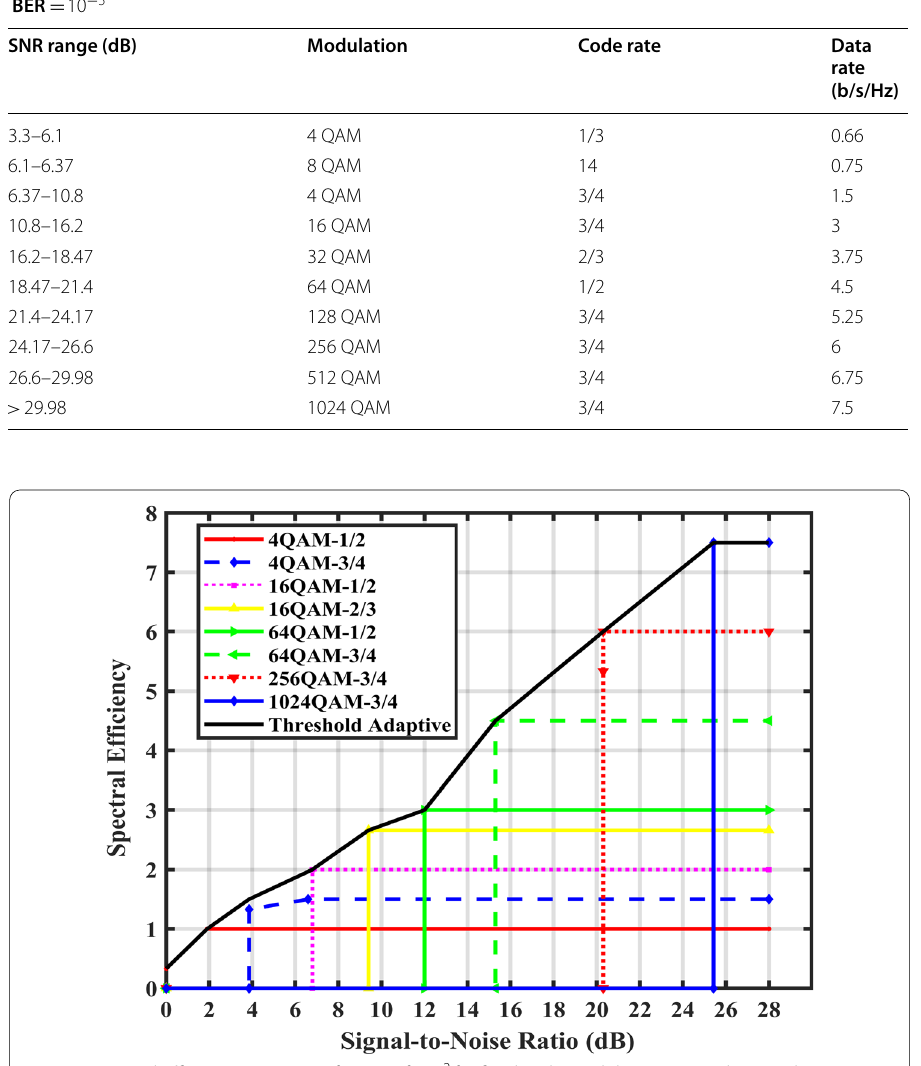
Fig. 19 Spectral efficiency versus SNR for BER of 10 − 2 for fixed code modulation pair and ACM schemes. The spectral efficiency (b/s/Hz) performance comparison with fixed and adaptive modulation code